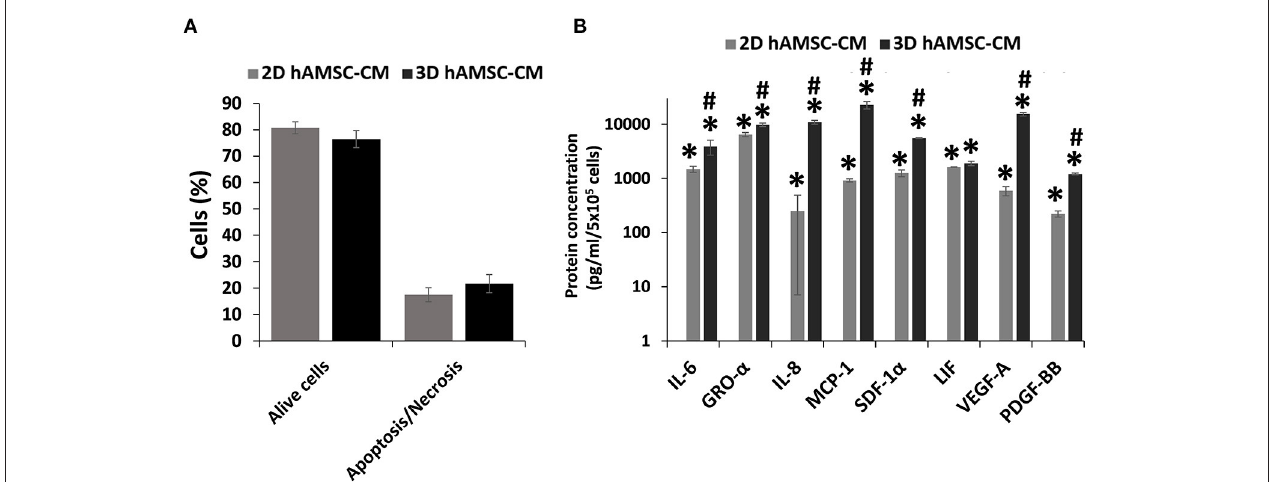
FIGURE 5 | Viability and secretion of cytokines/chemokines and growth factors in monolayer (2D) and spheroids cultures (3D) of human amnion-derived mesenchymal stem cells (hAMSCs). (A) Quantification of both alive and necrotic/apoptotic cells in 2D and 3D cultures of hAMSCs. (B) The conditioned medium (CM) was collected for both 2D and 3D hAMSCs cultured in differentiation medium (DM) for 72h and selected cytokines/chemokines and growth factors were analyzed. Data are means ± SD. * p < 0.05 vs. DM. # p < 0.05 vs. 2D